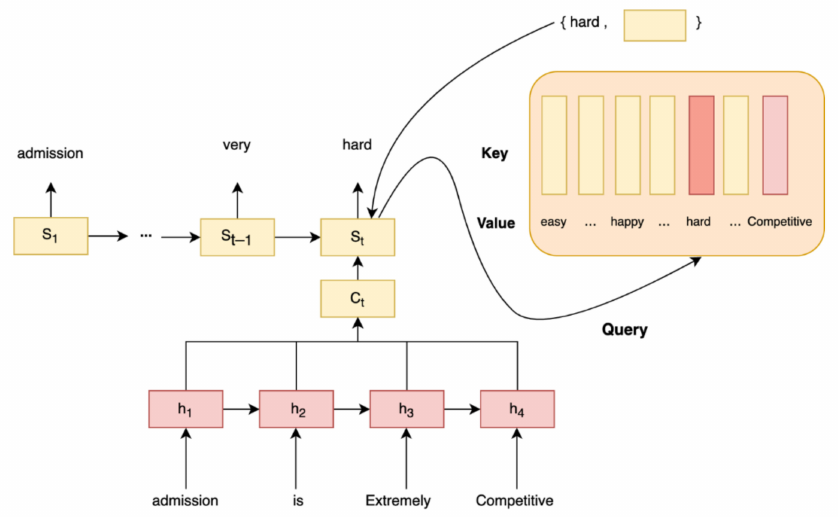
Figure 3. An overview of spam tweet paraphrasing